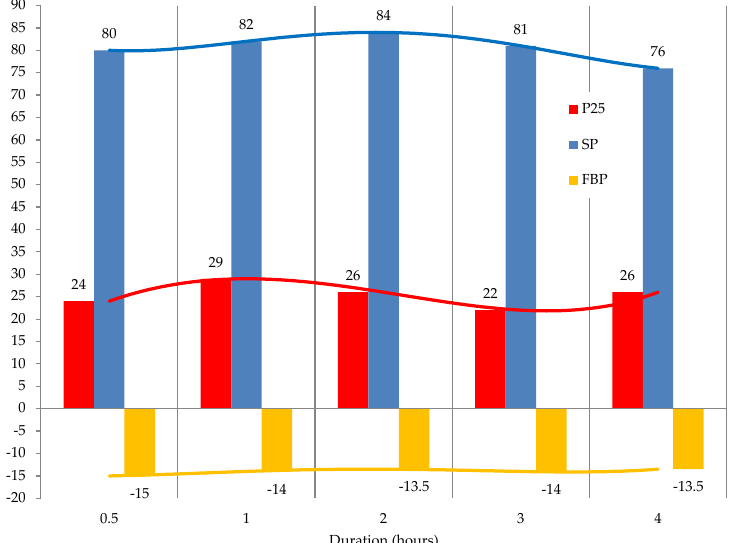
Figure 9. The effect of time on the modification process: raw is Т1; formalin amount (including formaldehyde) is 10.0 (3.7) kg/100 kg raw; catalyst amount (H 2 SO 4 ) is 2.5 kg/100 kg raw; temperature 100 °C.